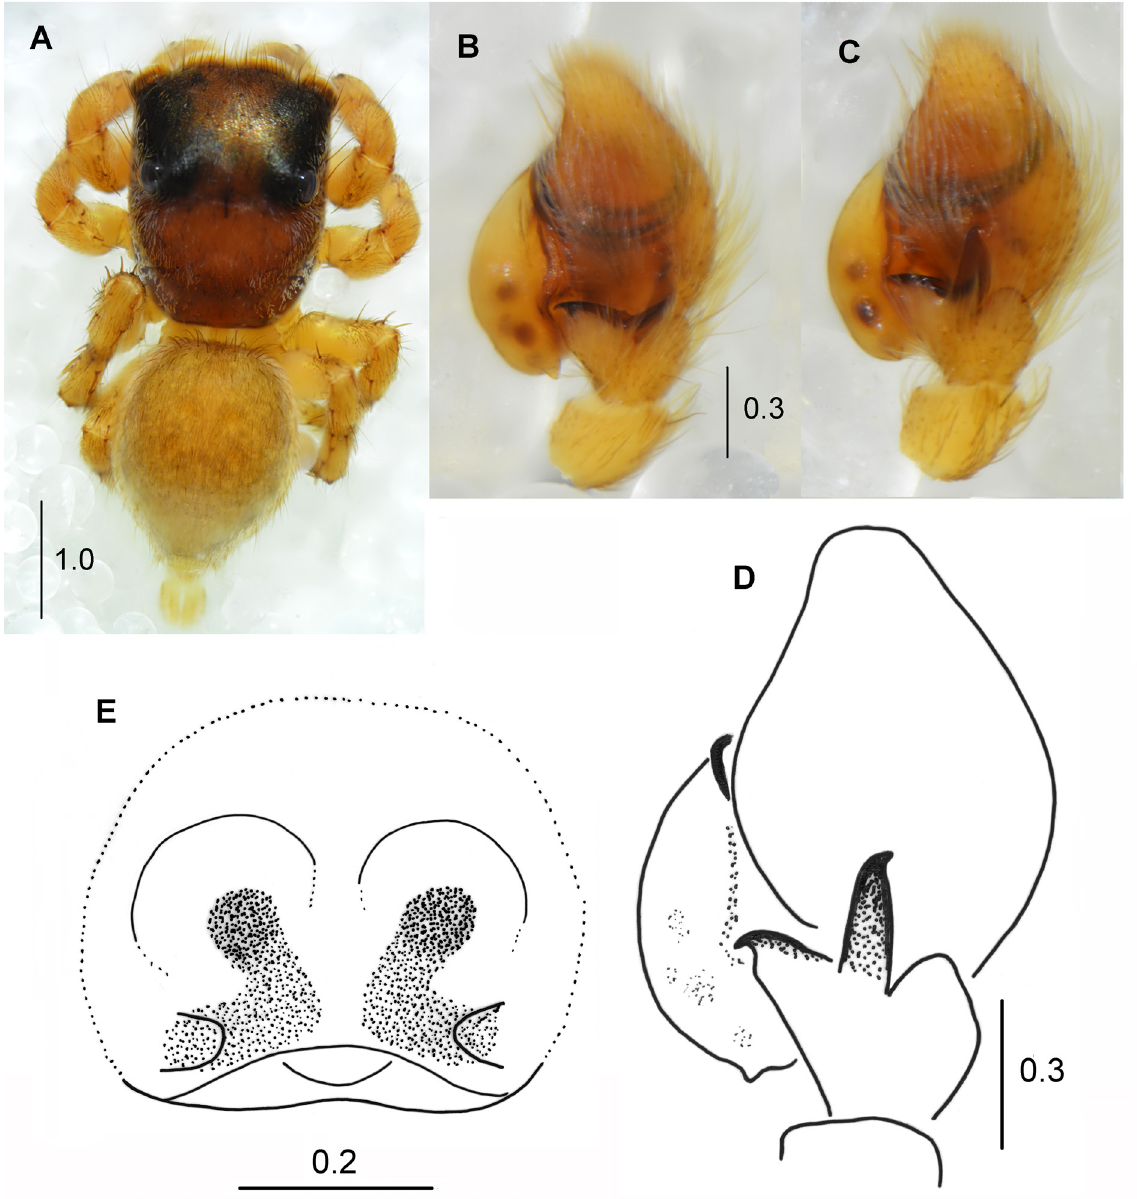
Fig. 31. Langelurillus nigritus (Berland & Millot, 1941), ♂♀ (MNHN). A . Habitus of male, dorsal view. B . Palpal organ, lateral view. C–D . Palpal organ, dorsal view. E .